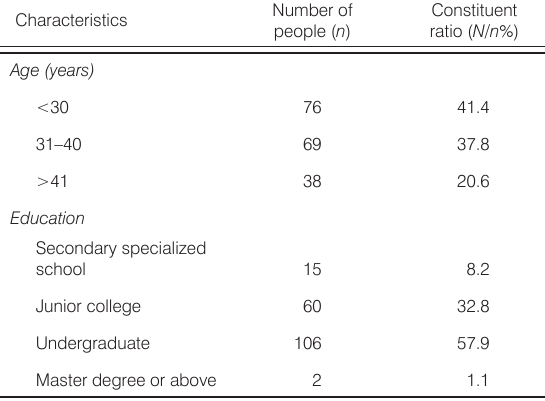
Table 1. Basic situation of obstetric nurses